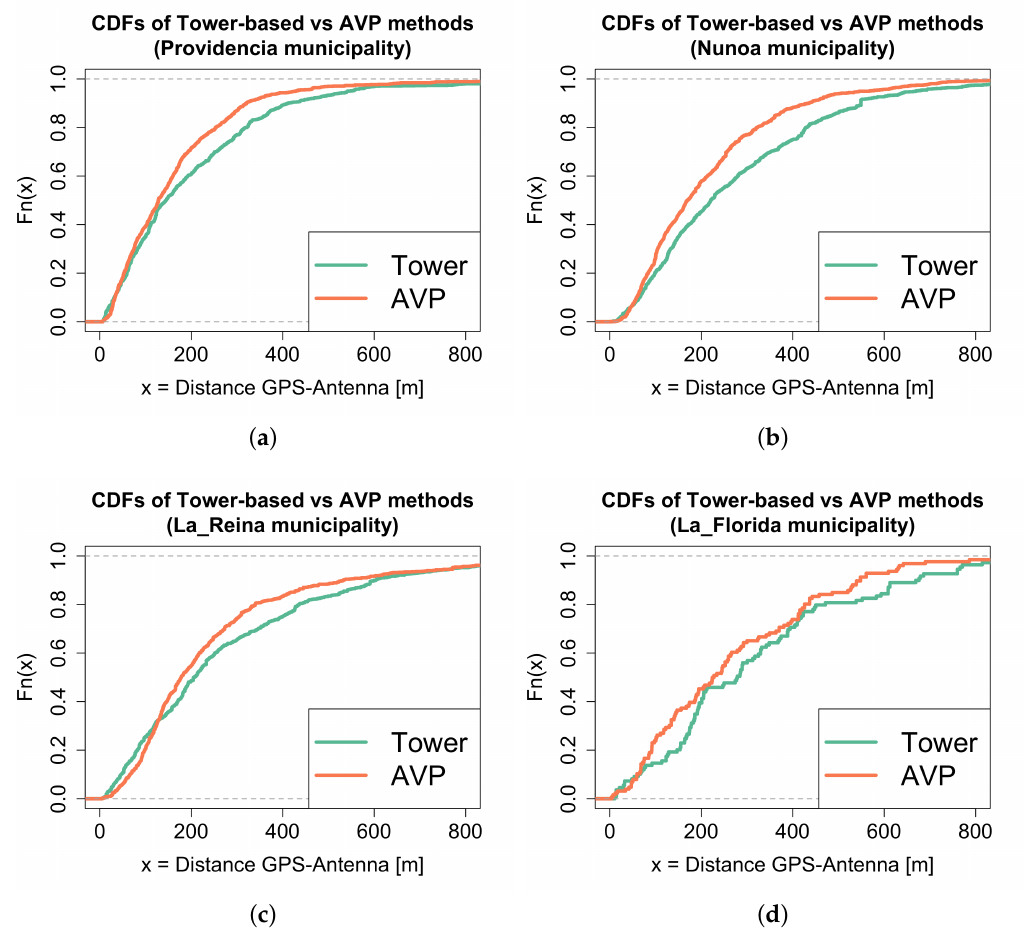
Figure 10. Accuracy measurement of the AVP and BTS-based positions with respect to ground-truth GPS positions of mobile devices. Particularly, we compare the cummulative distributions of distance between those methods and the ground-truth. The top row contains two municipalities with high antenna density: Providencia ( a ) and Ñuñoa ( b ); the bottom row contains two municipalities with low antenna density: La Reina ( c ) and La Florida ( d ). In all cases, AVP reduces the error introduced by using BTS-based positions to approximate device